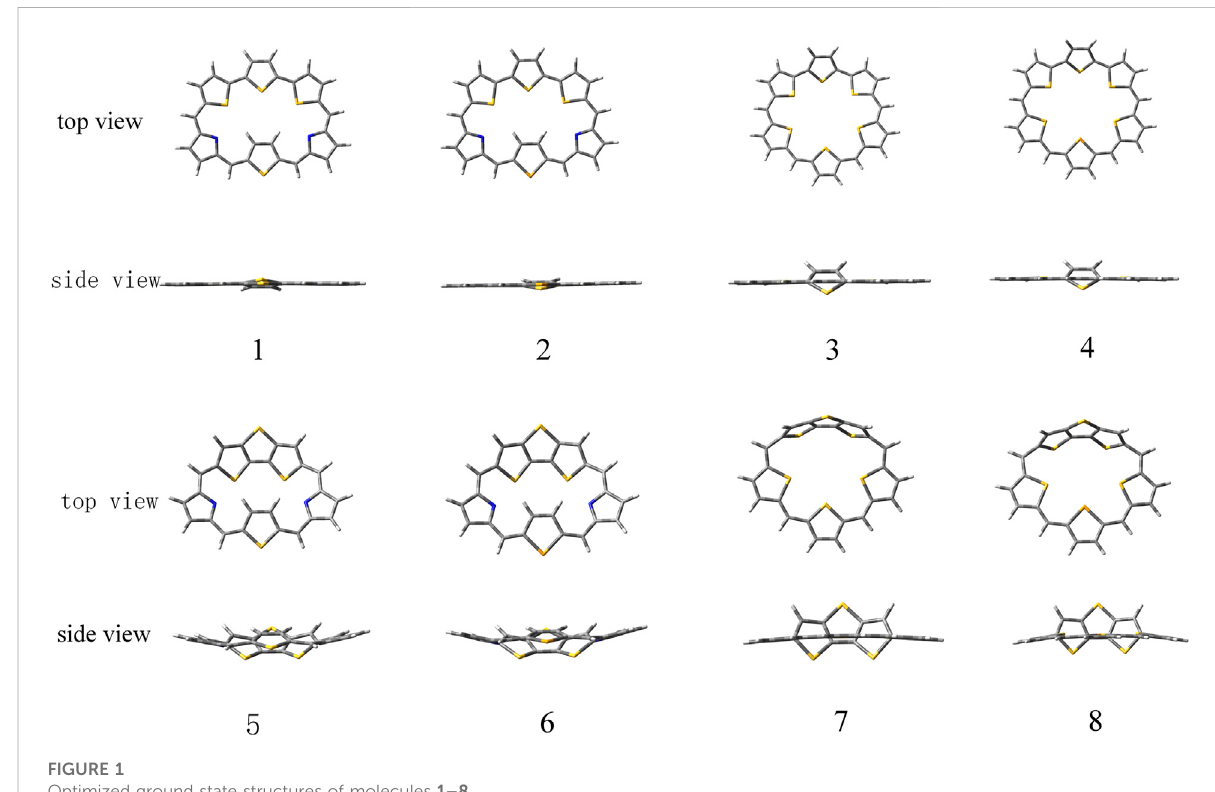
FIGURE 1 Optimized ground state structures of molecules 1 – 8 .